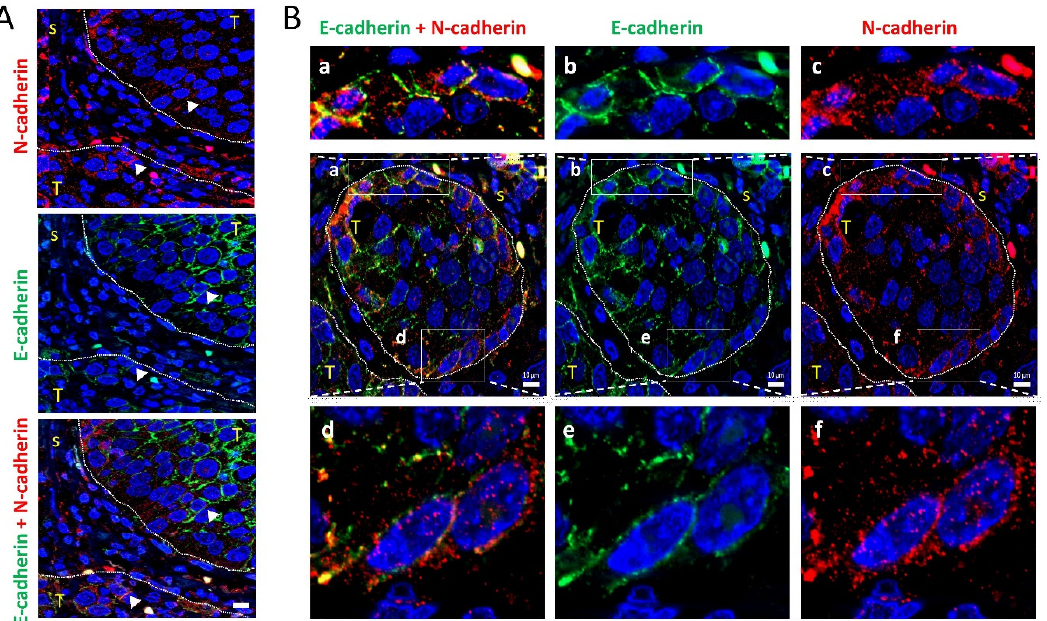
Figure 6. Colocalization of E-cadherin and N-cadherin in human head and neck SCCs. Double immunofluorescence labeling of two head and neck SCC tissue ( A and B ) for E-cadherin (green) and N-cadherin (red). Higher magnifications of the areas outlined in the pictures are shown at the upper and bottom parts of panel B to highlight the co-localization of E- and N-cadherin at the cell periphery. Dashed white lines denote the limits between tumor (T) and stromal (s) areas of the tissue. Scale bars: 10 μ m.